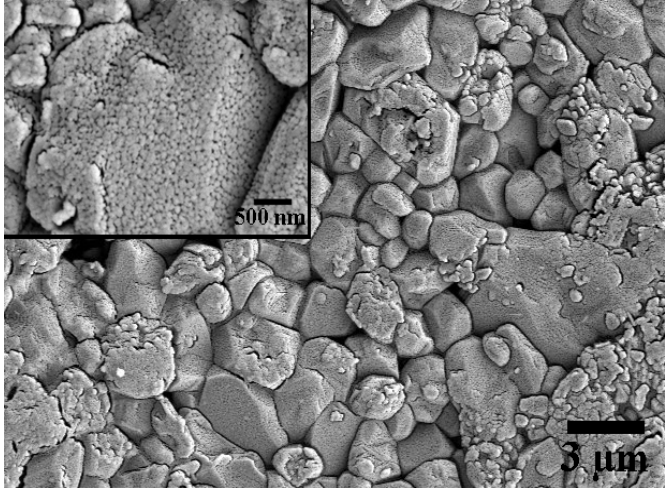
thin films on alumina 3